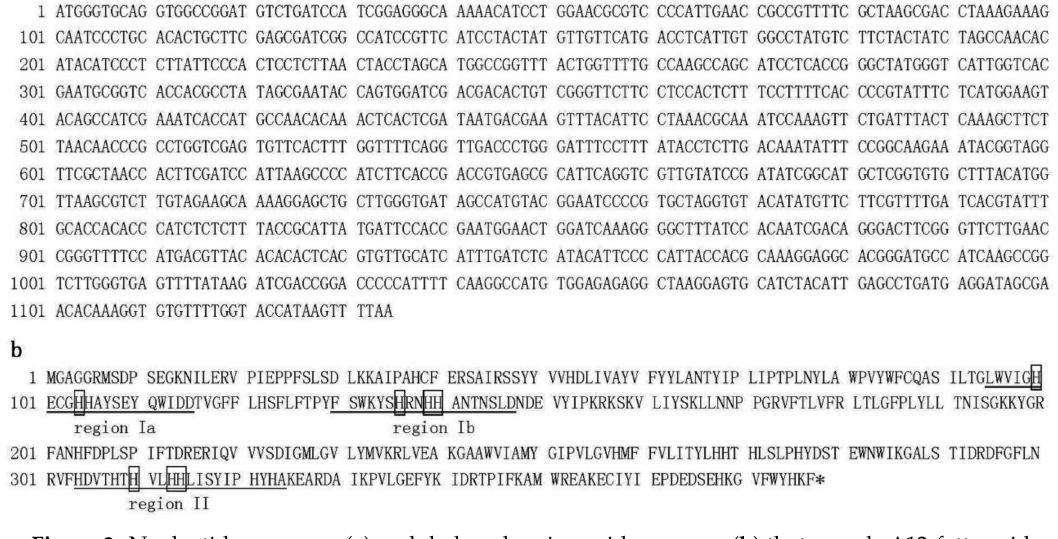
Figure 2. Nucleotide sequence ( a ) and deduced amino acid sequence ( b ) that encode ∆ 12-fatty acid acetylenase (BPFAA; accession number MF318525) from Bidens pilosa var. radiata . The eight conserved histidine residues are indicated by the boxes. Three regions (region Ia, region Ib, region II) of the catalytic sites are